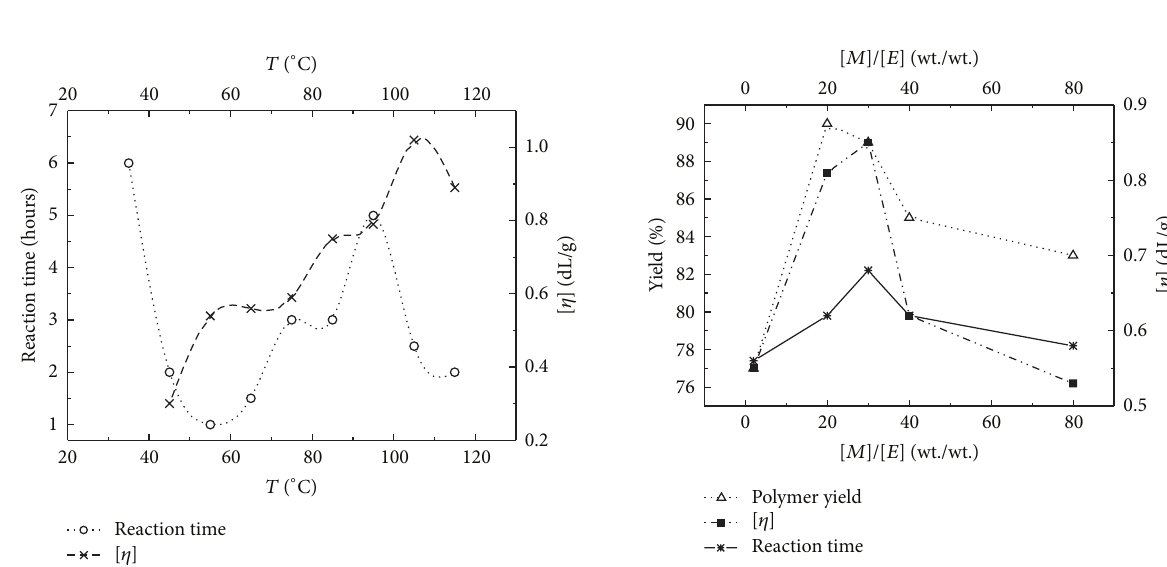
Figure 2: General scheme of matrix formation using TIPS technique.